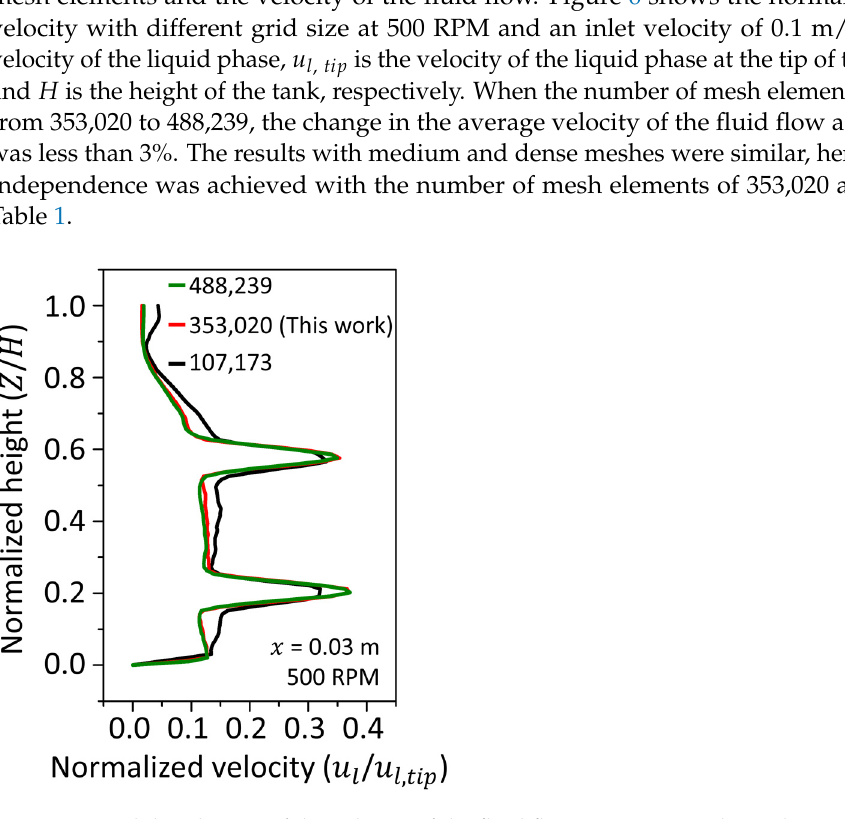
Figure 6. Axial distribution of the velocity of the fluid flow at x = 0.03 m depending on the number of mesh elements with 500 RPM and inlet velocity of 0.1 m/s. Table 1. The average velocity of the fluid flow and the average skewness depending on the number of mesh elements.